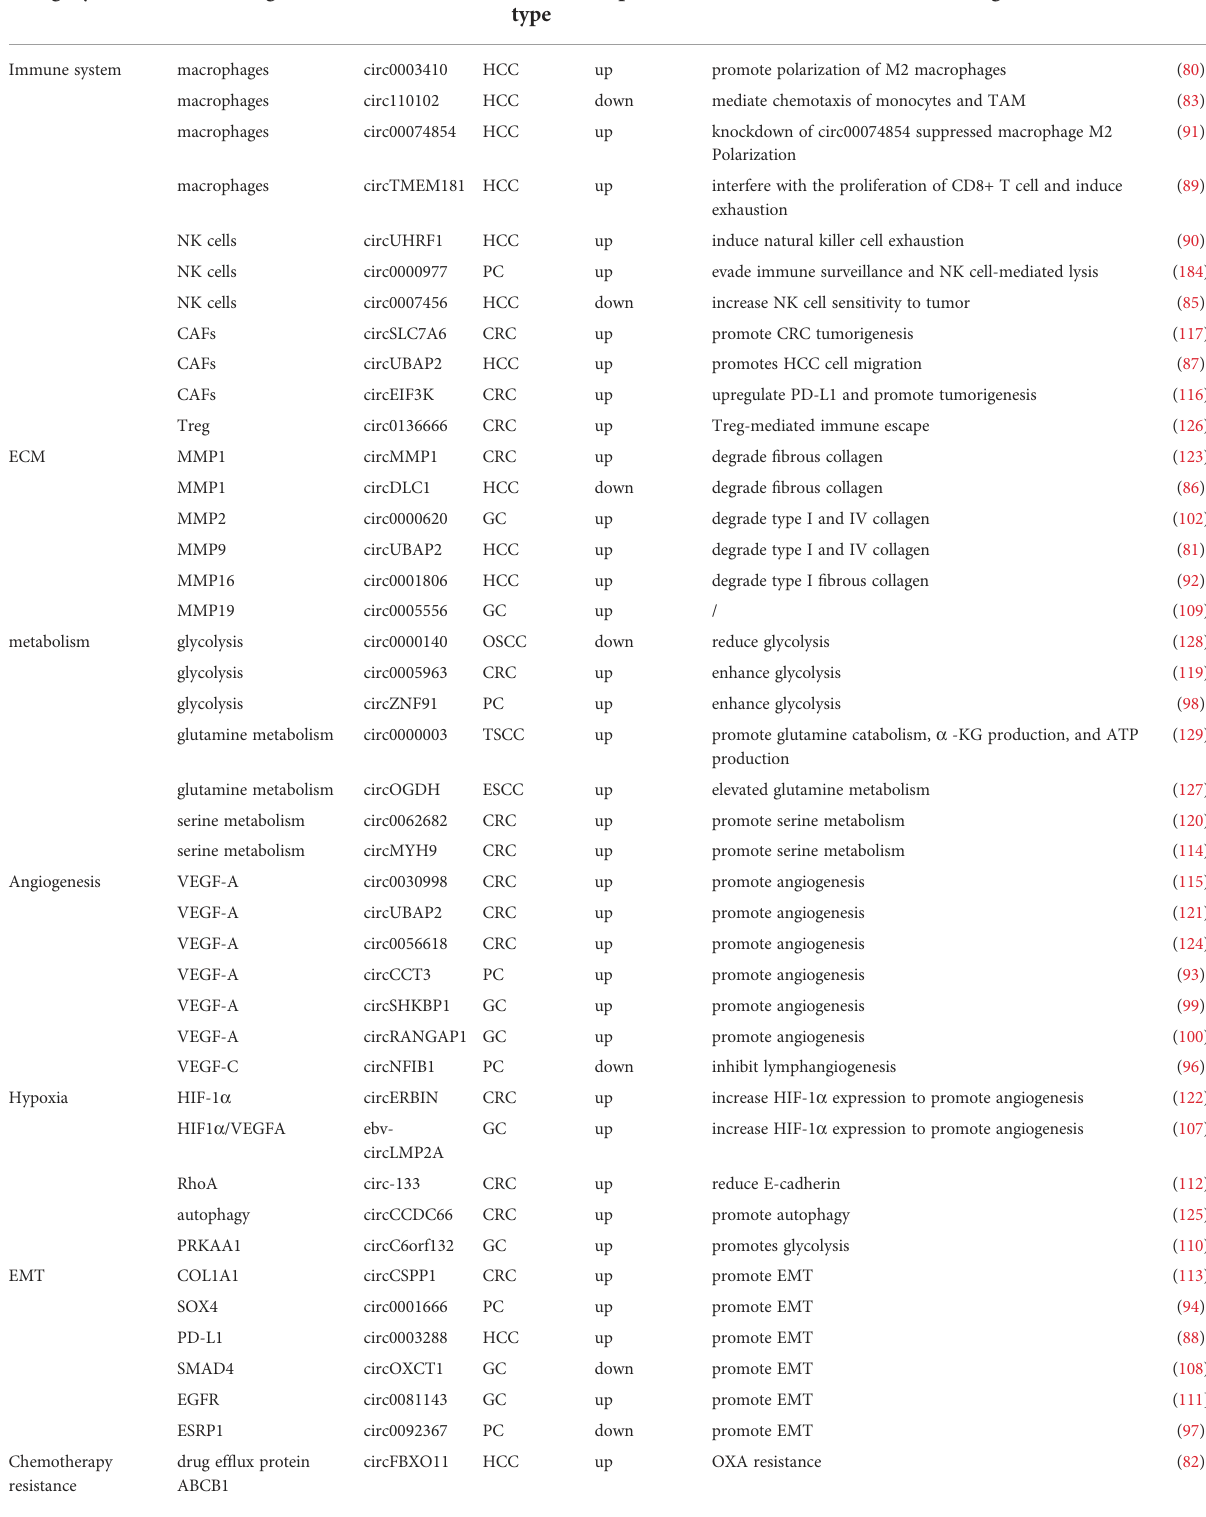
TABLE 3 Role of circRNAs in the tumor microenvironment of digestive system tumors. Category Target CircRNA Cancer